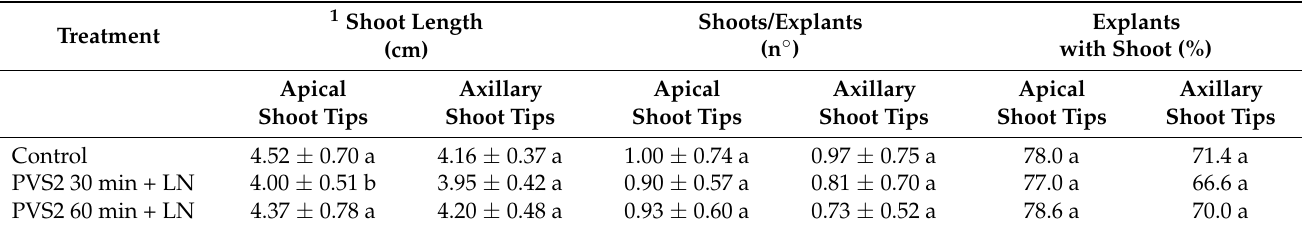
Table 4. First subculture after V cryo-plate procedure: morphological parameters of S. rebaudiana shoots, from control and from cryopreserved apical shoot tips and axillary shoot tips. (Means ± SD).